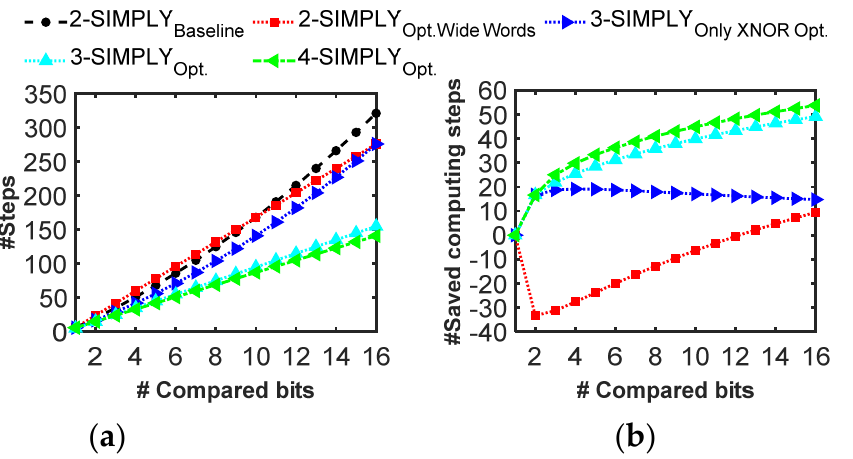
Figure 11. Analysis of the comparator implementation for increasing n of the n-SIMPLY operation and number of compared bits. Both the total number of computing steps and the percentage of saved computing steps are reported in ( a , b ), respectively. The use of optimized sequences for the 3-SIMPLY (i.e., 3-SIMPLY Opt. ) and 4-SIMPLY (i.e., 4-SIMPLY Opt. ) operations considerably reduces the number of computing steps.